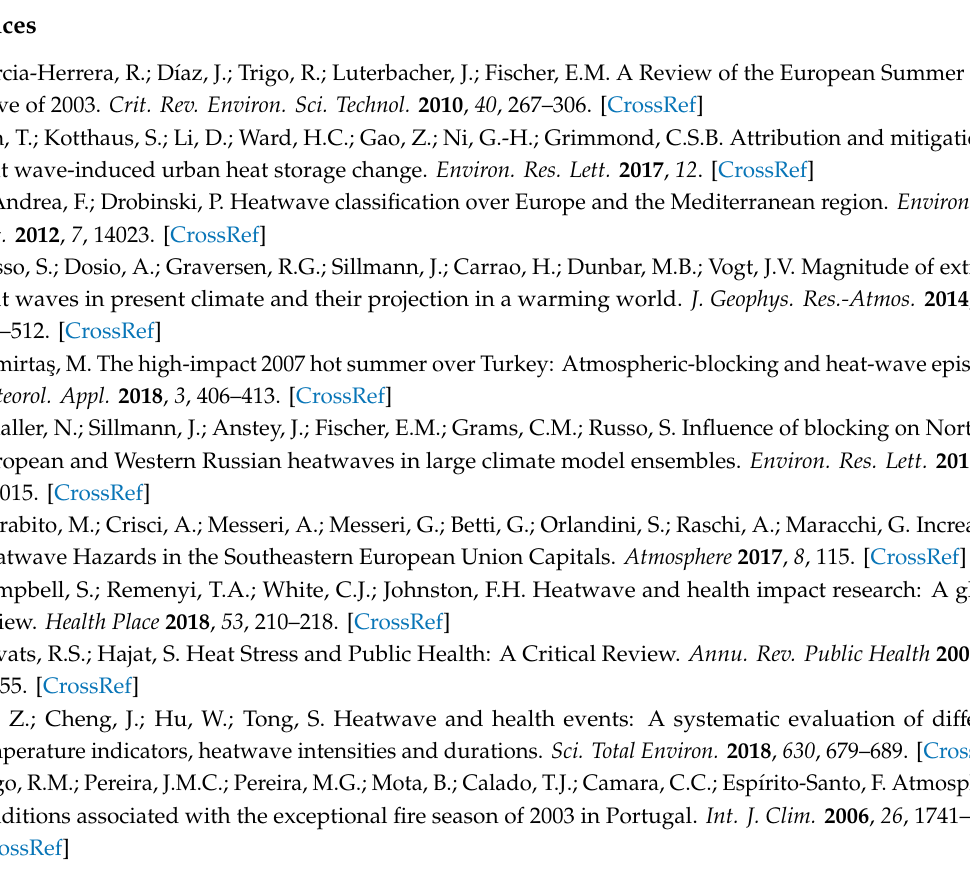
Figure S1—Annual average of (a) NWAVES and (b) DUR for EOBS, WRF CORDEX average, maximum and minimum (vertical bar) for HIST BC, Figure S2—(a) INT and (b) RF average of HW for EOBS, WRF CORDEX average, maximum and minimum (vertical bar) for HIST BC, Figure S3—(a) Tmax_ave average of HW and (b) Annual average of Tmax_sum for EOBS, WRF CORDEX average, maximum and minimum (vertical bar) for HIST BC, Figure S4—(a) Maximum HW DUR, (b) Maximum HW INT, (c) Maximum HW Tmax ave, (d) Absolute maximum HW Tmax and (e) Maximum Tmax sum, for WRF HIST, MED and LONG, and CORDEX average, maximum and minimum for MED and LONG, Figure S5—Monthly average of (a) NWAVES, (b) DUR, (c) INT and (d) Tmax_ave and (e) Absolute maximum of Tmax for HIST, MED and LONG simulated by WRF, Figure S6—Tmax during the 2003 extended HW (i.e., 19 days) in Lisbon. The ‘envelope’ shows maximum and minimum Tmax recorded by the nine meteorological stations. The grey period represents the 5-day HW identified using the criteria used in this study. The black line is Tmax_c from EOBS, Table S1—Meteorological stations operated by IPMA and respective ID and coordinates for the Lisbon area, Table S2—HW measures of the 2003 HW for the 19 days. ‘ave’ and ‘max’ su ffi xes are average and maximum values across all nine stations, Table S3—The same as Table S4 but considering only the 5 days identified by the application of the HW